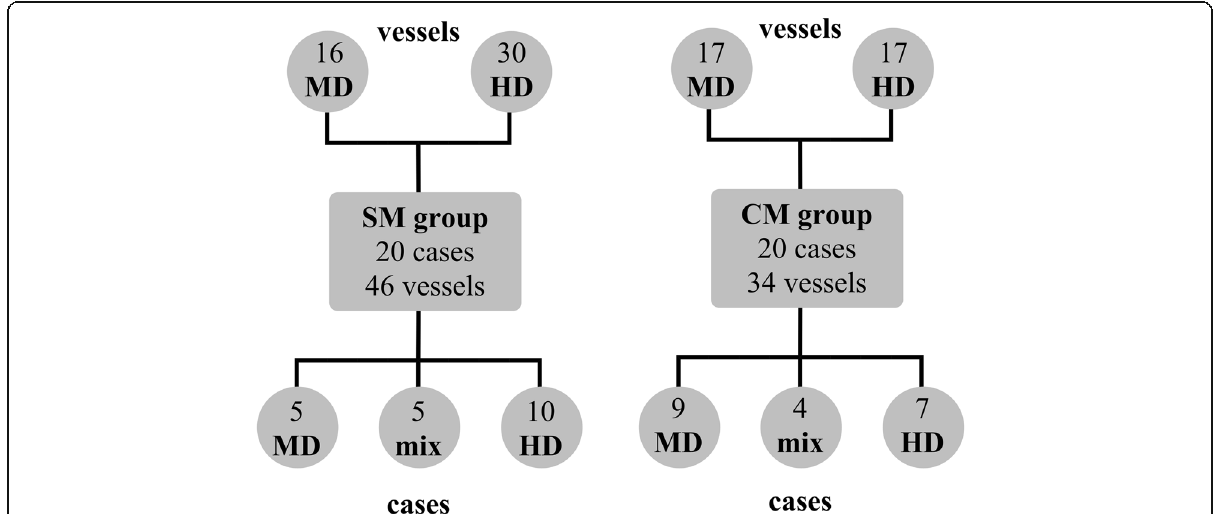
Fig. 1 Breakdown of SM and CM cases into MD/HD/mix subgroups and all SM and CM vessels into MD or HD subgroups